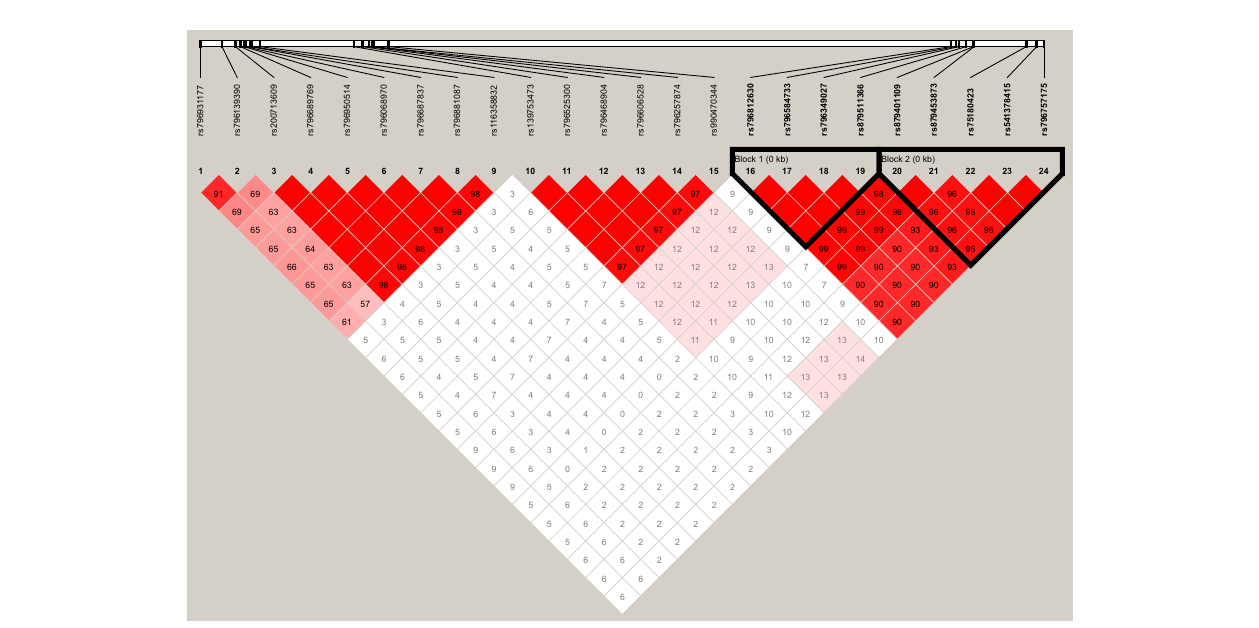
FIGURE 4 | The linkage disequilibrium (LD) plot depicts the structure of haplotype blocks encompassing the 24 single-nucleotide polymorphisms (SNPs) located in the RFTN1 gene in our Chinese Han population. This plot was generated using Haploview (https://www.broadinstitute.org/haploview/haploview). The standard Haploview LD color scheme based on D ’ has been applied. The value of 100 x D ’ is displayed for each SNP pair ’ s tile unless D ’ =